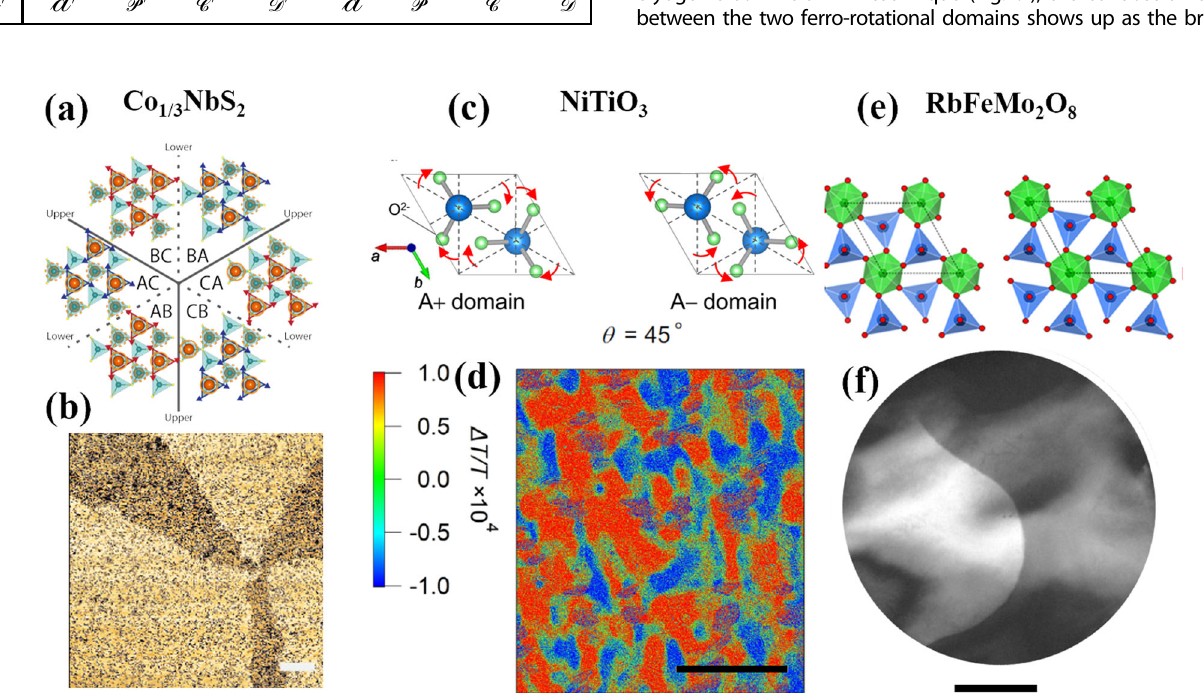
Fig. 6 Visualization of domains associated with various broken symmetries. a A Z 6 vortex of Co 1/3 NbS 2 with chiral domains. b Chirality- dependent SP-STM unveils a Z 6 vortex 27 . (scale bar = 20 nm). c The atomic structure of ferro-rotational domains of NiTiO 332 . d Ferro-rotational domains in NiTiO 3 visualized with an electro-gyration technique. (scale bar = 100 μ m). e The atomic structure of ferro-rotational domains of RbFe(MoO 4 ) 2 . f Ferro-rotational domains observed in TEM on RbFe(MoO 4 ) 238 (scale bar = 500